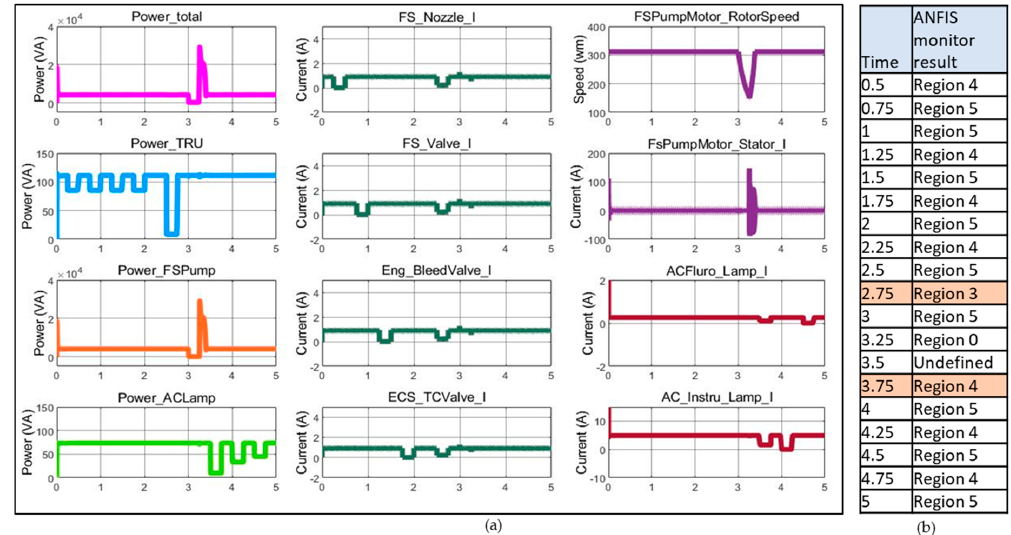
Figure 10. Faulty scenario using the crisp boundary approach. ( a ) EPS performance in faulty scenarios. ( b ) The corresponding results generated by ANFIS monitor using Method 1 approach.